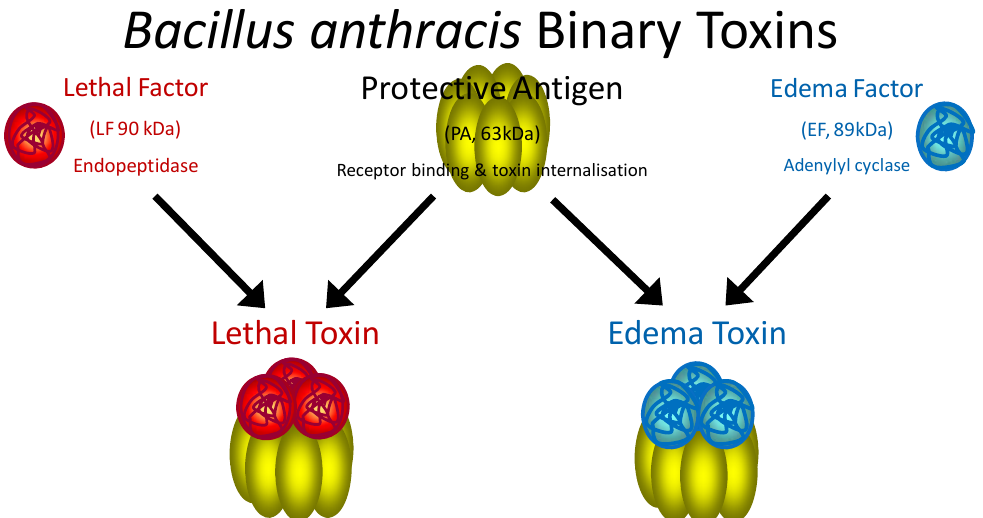
Figure 1. Bacillus anthracis secretes three toxin-associated proteins, lethal factor (LF), protective antigen (PA), and edema factor (EF) which form the two binary anthrax toxins. ) is an 83 kDa protein responsible for toxin entry into the cell. PA Protective antigen (PA 83 binds receptors at the cell surface where it is cleaved by a furin-like protease removing a 20 kDa portion. The remaining 63 kDa PA forms an oligomer at the cell surface that 63 binds three molecules of lethal factor (LF), a zinc-endopeptidase, and edema factor (EF), adenylyl cyclase, forming lethal toxin and edema toxin